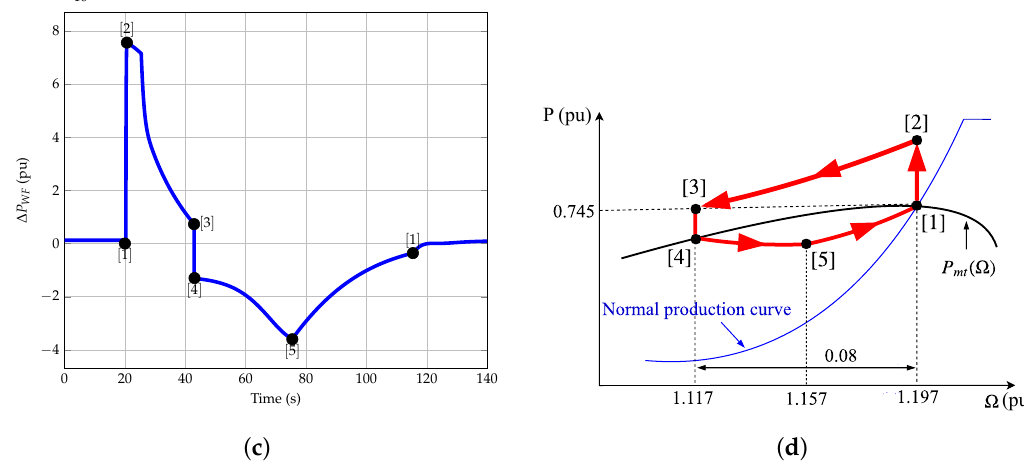
Figure 22. Wind power plant response for scenario 2 and adaptive and smoother frequency controller with x = 0.75. ( a ) Frequency deviation; ( b ) Rotational speed; ( c ) Variation of wind power; ( d ) Frequency control